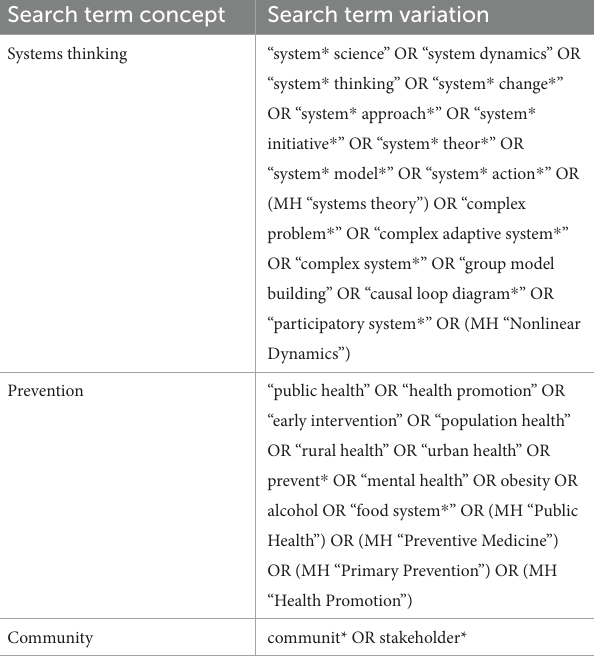
TABLE 1 Search term concepts and